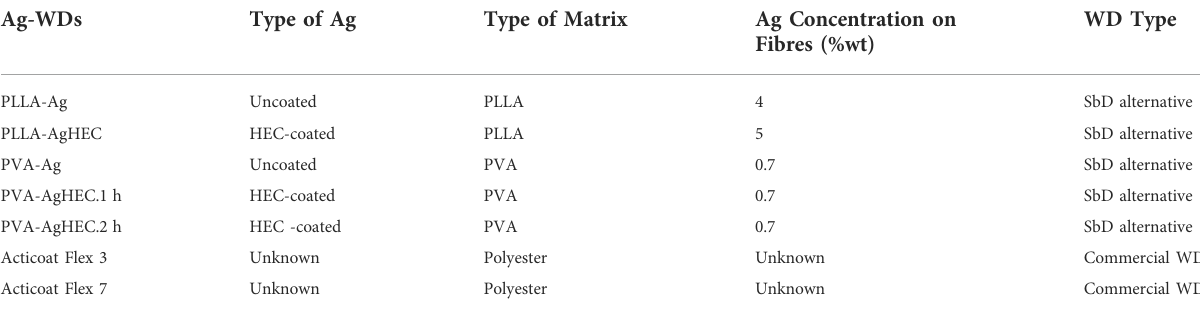
TABLE 1 Ag-WDs and their main characteristics.